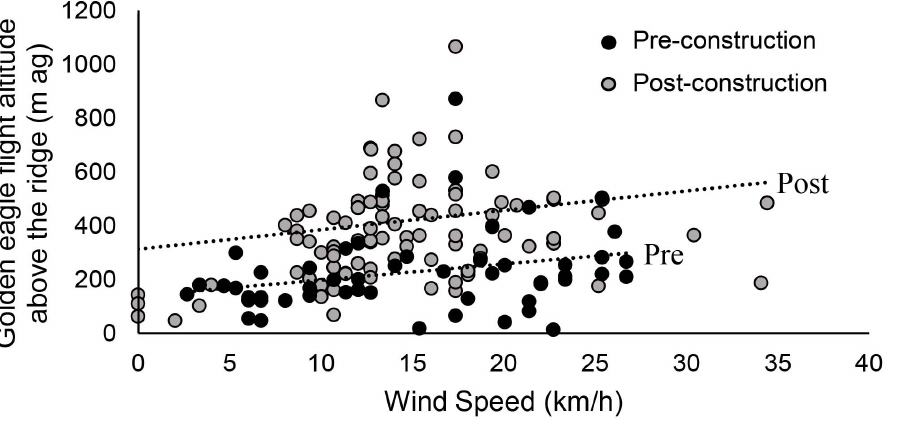
Figure 5. Golden eagle altitude (m above ground) over ridge top by wind speed (km/h). Golden eagle flight altitude above the ridge-top area (m above ground) versus ground-based wind speed (km/h) during pre- ( n =60) and post-construction ( n =148) years. Some data points overlap. Grey box represents higher-risk flight zone (risk zone [ # 150 m above ground] and above turbine cut-in speed [6.8 km/h]).